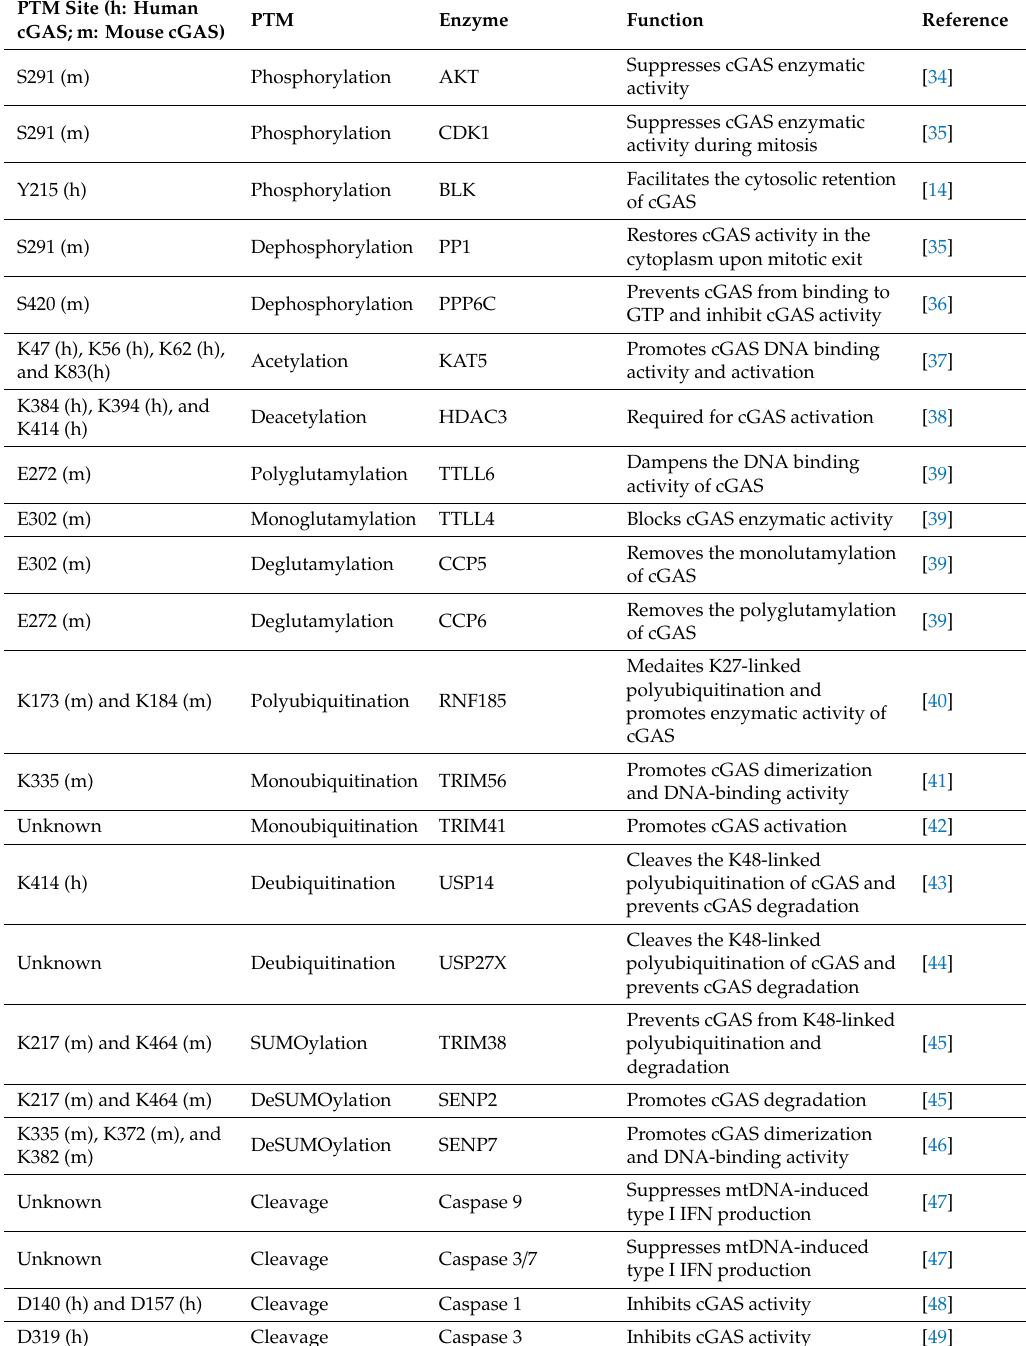
Table 1. The cGAS post-translational modification (PTM) sites and their relative